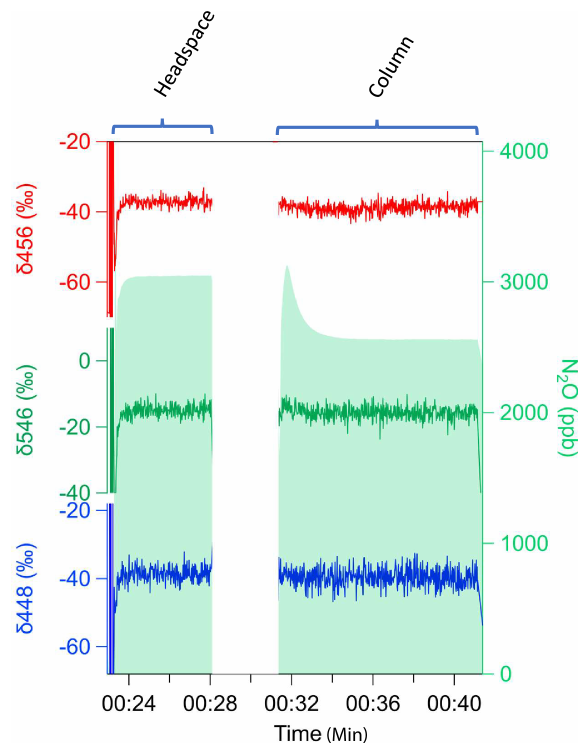
Figure 5. Headspace and probe measurements of N 2 O using sil- ica in System 2 (CH 4 –N 2 O). Example of initial pulse that equili- brates under flow-through and incomplete diffusion of N 2 O con- centration (green shade) with undetectable isotopic fractionation of isotopomers δ 456 (red), δ 546 (green), and δ 448